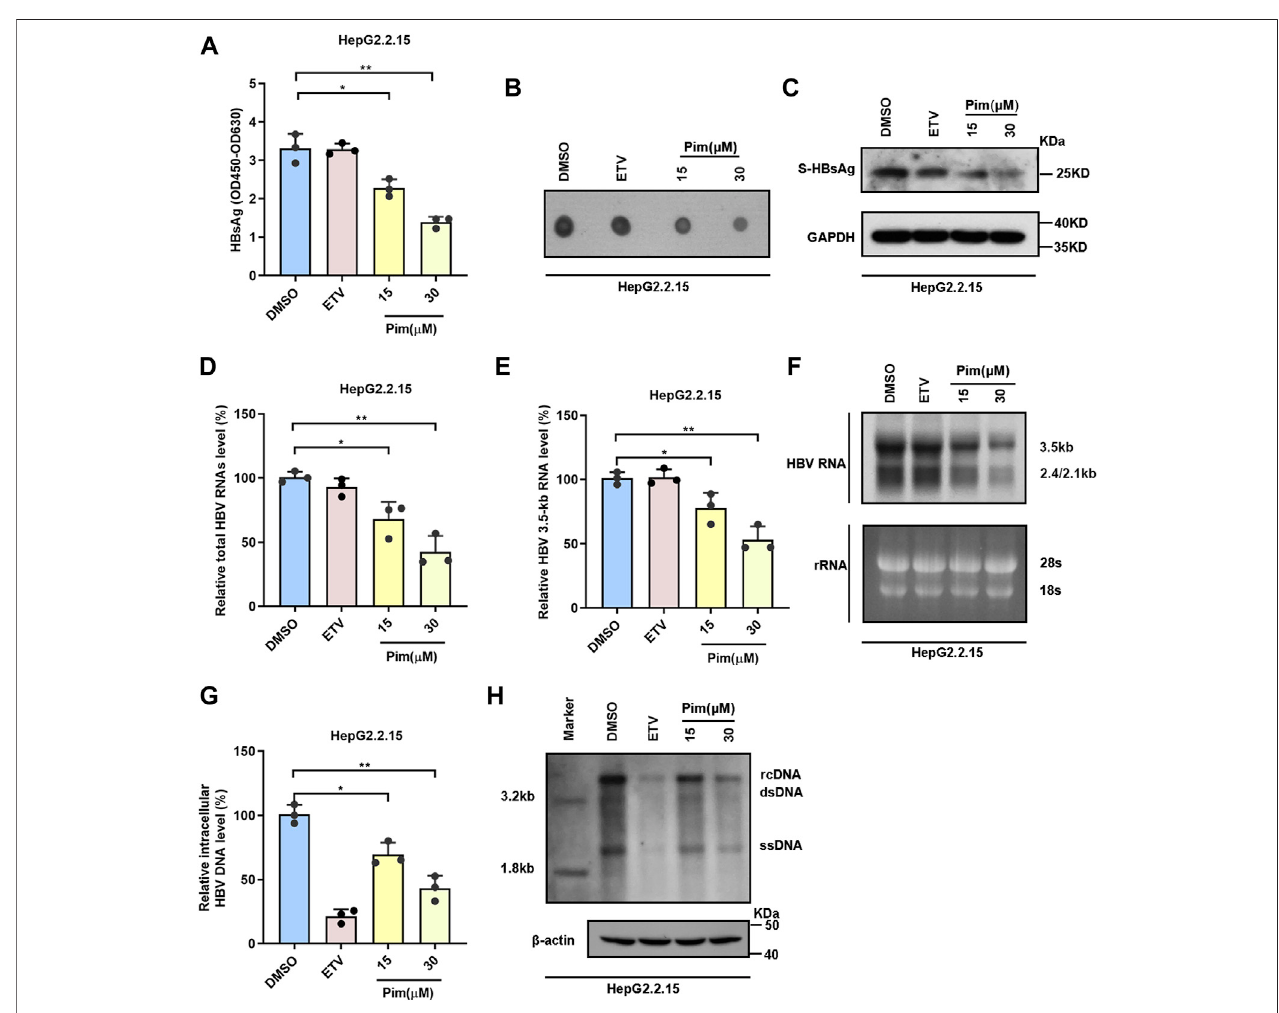
FIGURE 3 | Pim inhibits HBsAg production and HBV replication (A – B) HepG2.2.15 cells were treated with DMSO, 25 nM ETV and 15 or 30 μ M Pim respectively. the HBsAg level in the supernatant were determined by ELISA and dot blot assay (C) Western blot was used to detect the intracellular HBsAg in HepG2.2.15 (D – E) In HepG2.2.15cells,relativereal-timePCRwassubjectedtodetectthetotalHBVRNAsandHBV3.5-kbRNAlevels,ThemRNAlevelof β -actinwasusedasinternalcontrol (F) Northern blot was applied to determine the HBV RNAs, the rRNA level of 28S and 18S were used as an internal control (G – H) The quanti fi cation PCR and SouthernblotwereperformedtodeterminethelevelofHBVcoreDNAafterPimtreatmentinHepG2.2.15,Thelevelof β -actinwasusedasaloadingcontrolforHBVcore DNA.Thedataarethemean±SDfromthreeindependentexperiments.rcDNA,relaxedcircularDNA;dsDNA,double-strandDNA;ssDNA,single-strandDNA(* p < 0.05; ** p <